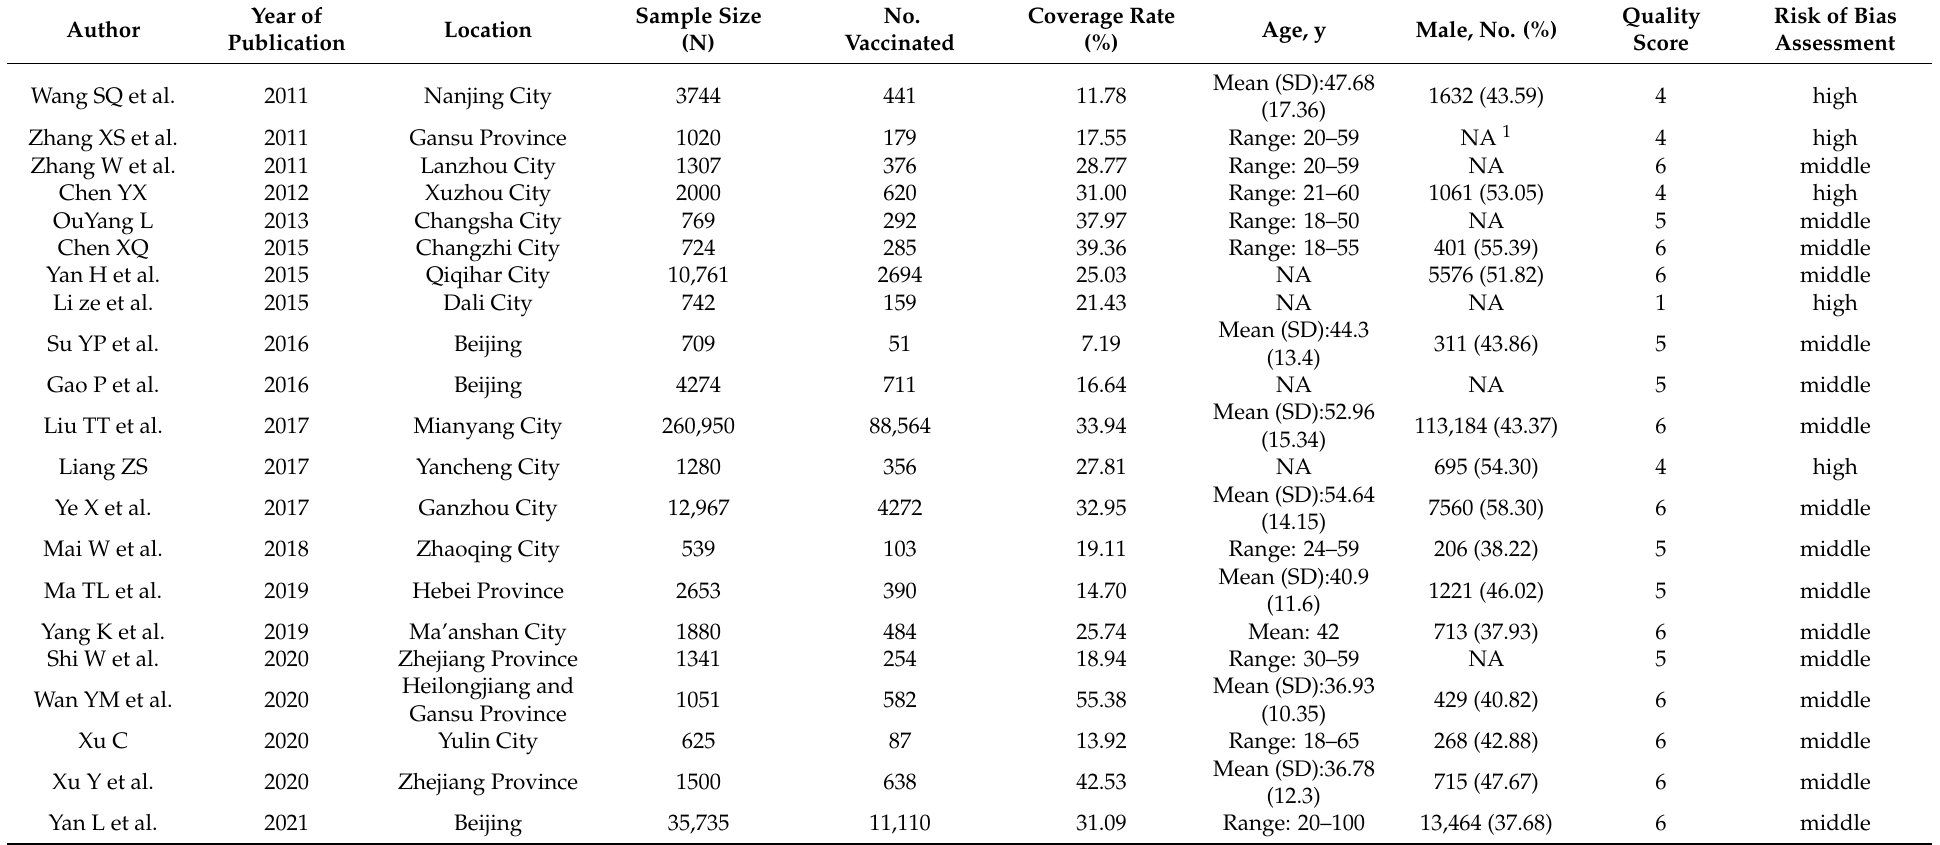
Table 1. Characteristics of the included